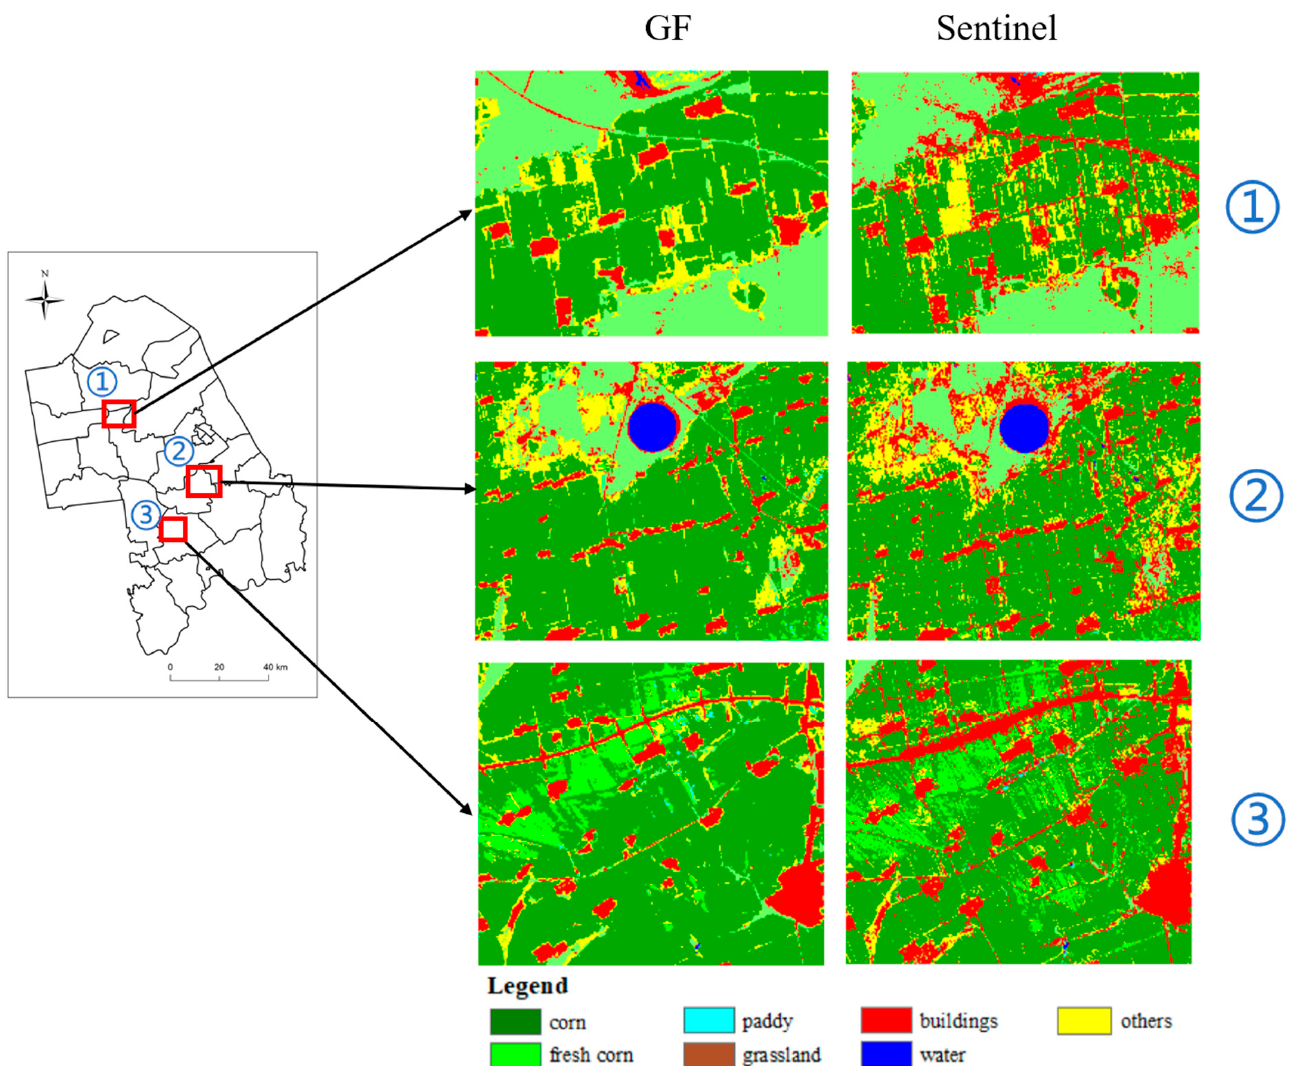
Figure 6. Details of the GF and Sentinel image classification results (reference frame: WGS84/UTM51N).